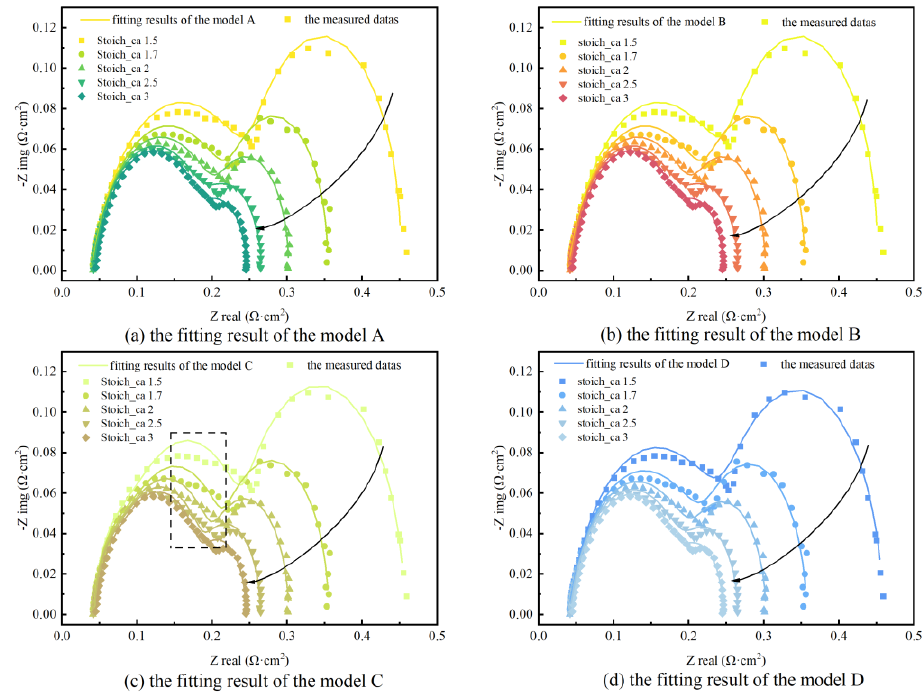
Figure 5. The model-fitting results under different air stoichiometry: ( a ) the fitting result of the model A; ( b ) the fitting result of the model B; ( c ) the fitting result of the model C; ( d ) the fitting result of the model D. Table 3. Chi-square values of the model fitting results under different air stoichiometry.